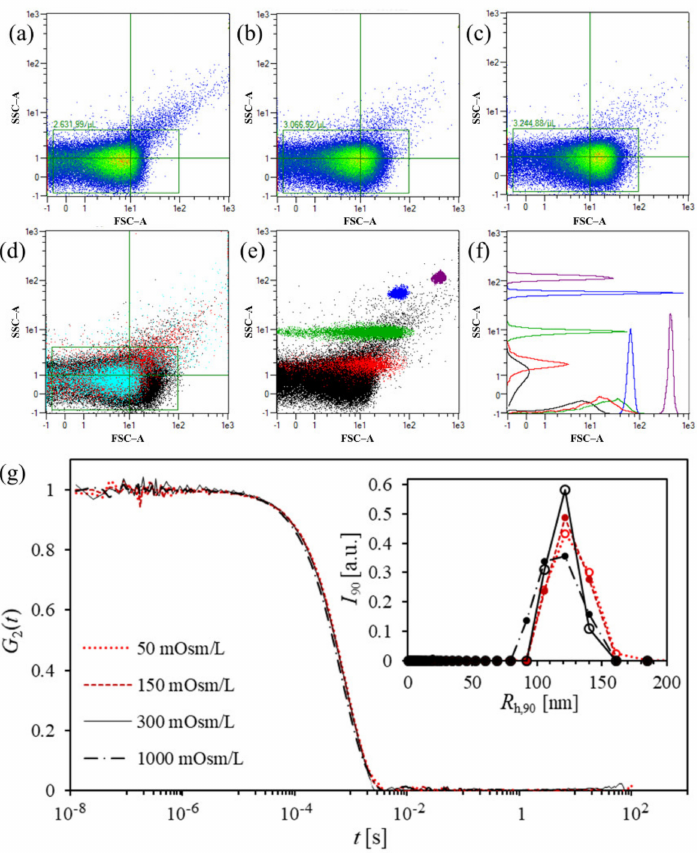
Figure 2. FCM and DLS/SLS analysis of hbEV isolates. ( a – d ) Scatterplot presenting forward (FSC–A) and side-scattering (SSC–A) signals of hbEV isolates suspended in media with different